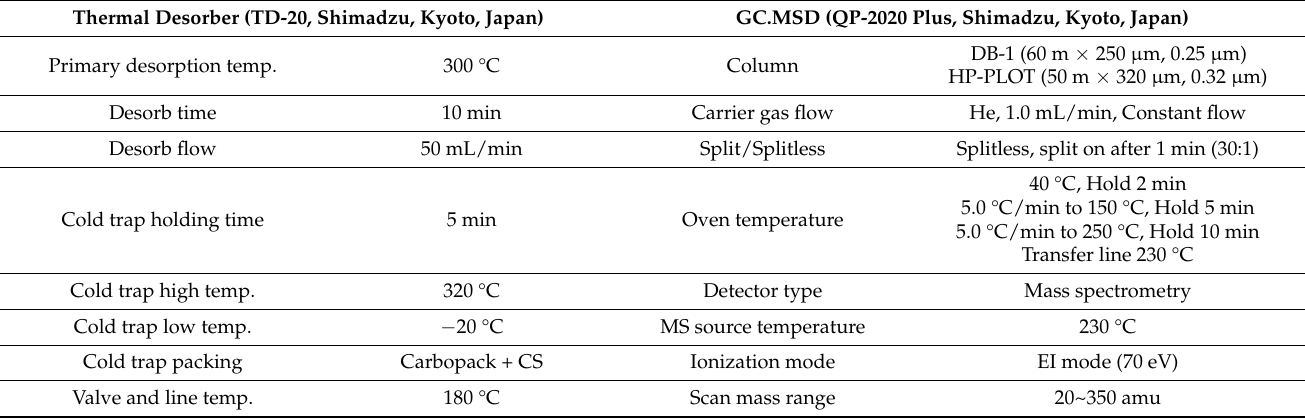
Table 6. Operating conditions of thermal desorption and GC/MS for VOC